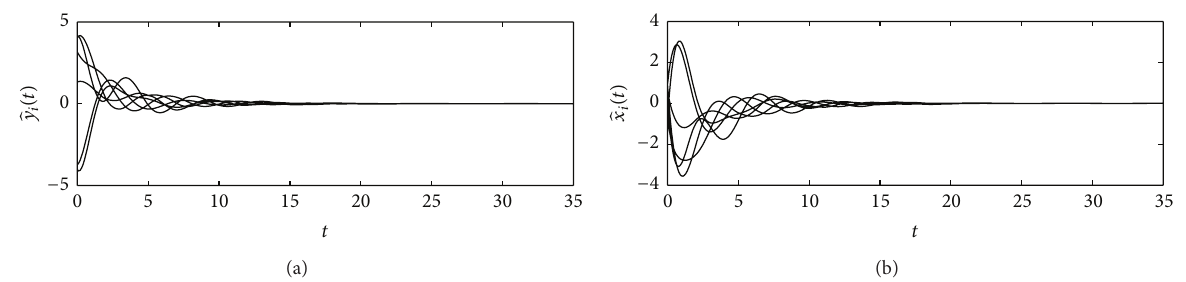
Figure 4: The evolution curves of the error states of supply networks under control